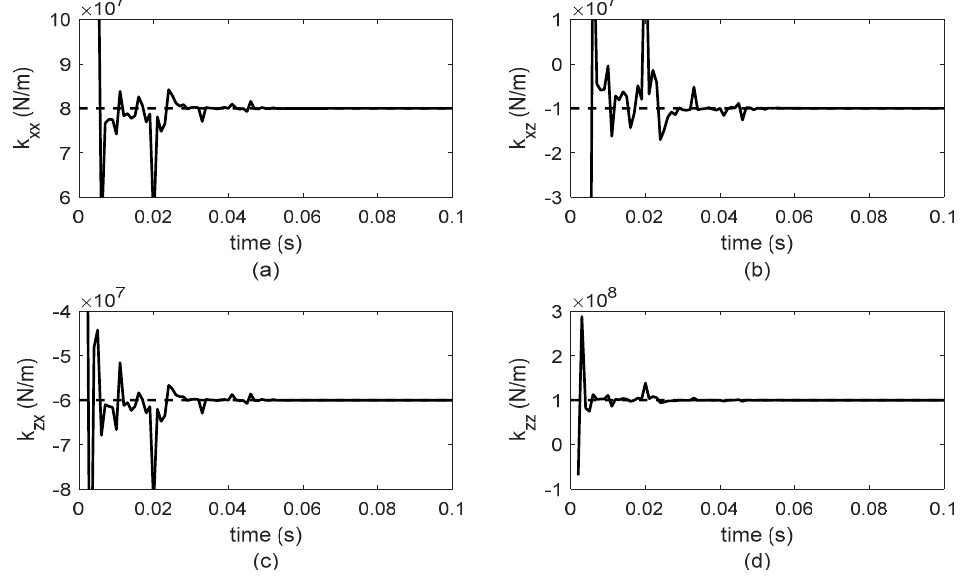
Figure 10. Identified stiffness parameters for bearing 1 with a linear ramp of excitation of 10 rad / s 2 . ( a ) (cid:1863) (cid:3051)(cid:3051) , ( b ) (cid:1863) (cid:3051)(cid:3053) , ( c ) (cid:1863) (cid:3053)(cid:3051) , ( d ) (cid:1863) (cid:3053)(cid:3053) .